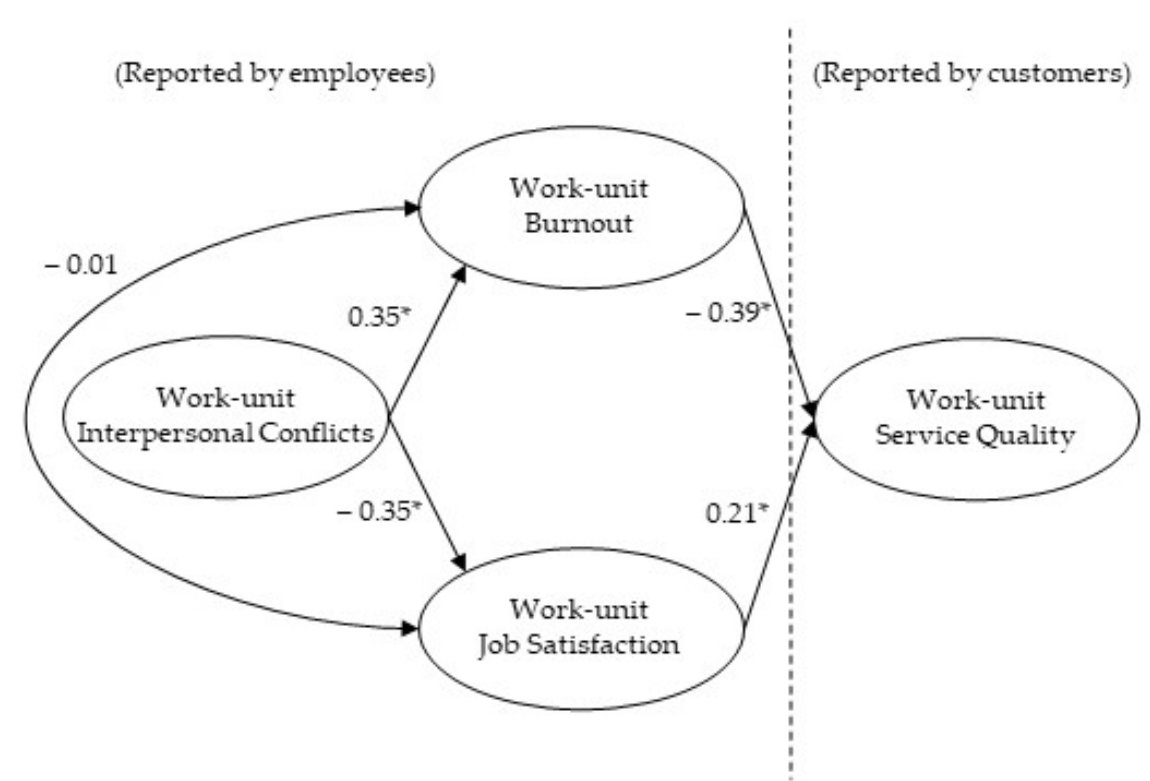
Figure 2. Full mediation model. * p < 0.01. Standardized coefficients.